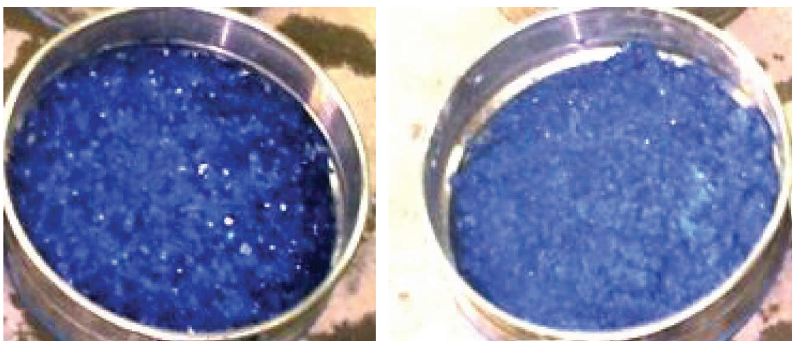
Figure 2: Recycled glass coarse and fne aggregate.